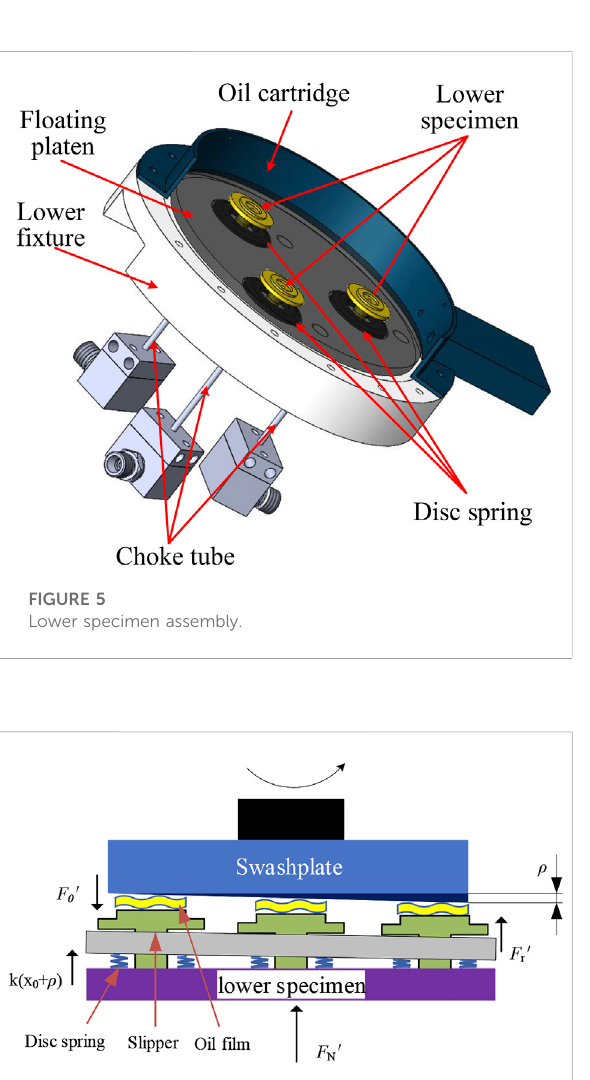
FIGURE 4 Upper specimen assembly.